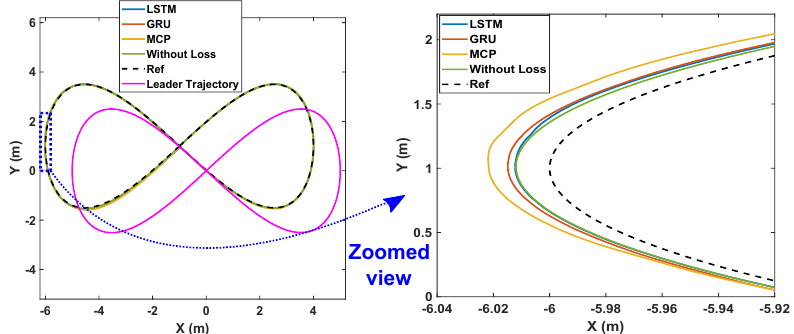
Figure 14. Trajectory of the robots during formation control (packet loss—50%).